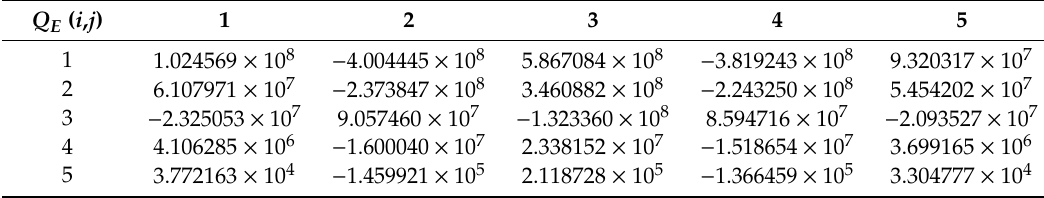
Table A2. The coe ffi cient matrix Q E